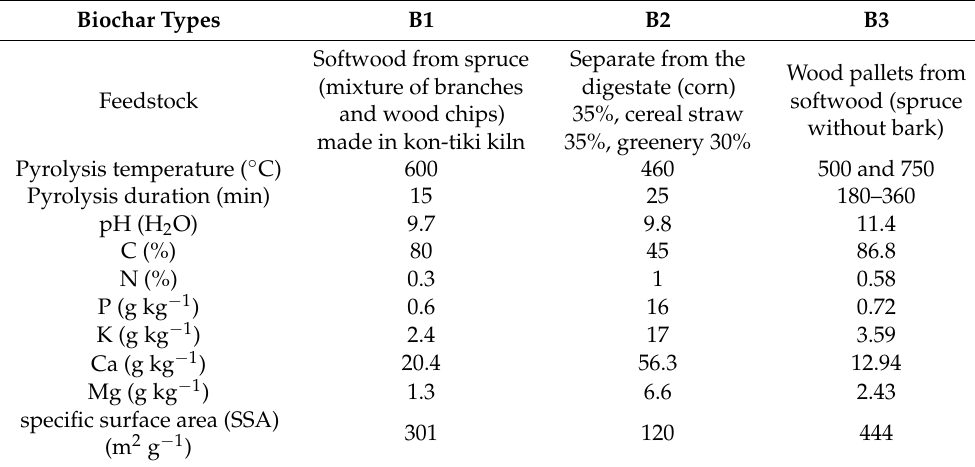
Table 1. Biochar feedstock, pyrolysis temperature, pyrolysis duration, and physicochemical properties of three biochars used in this